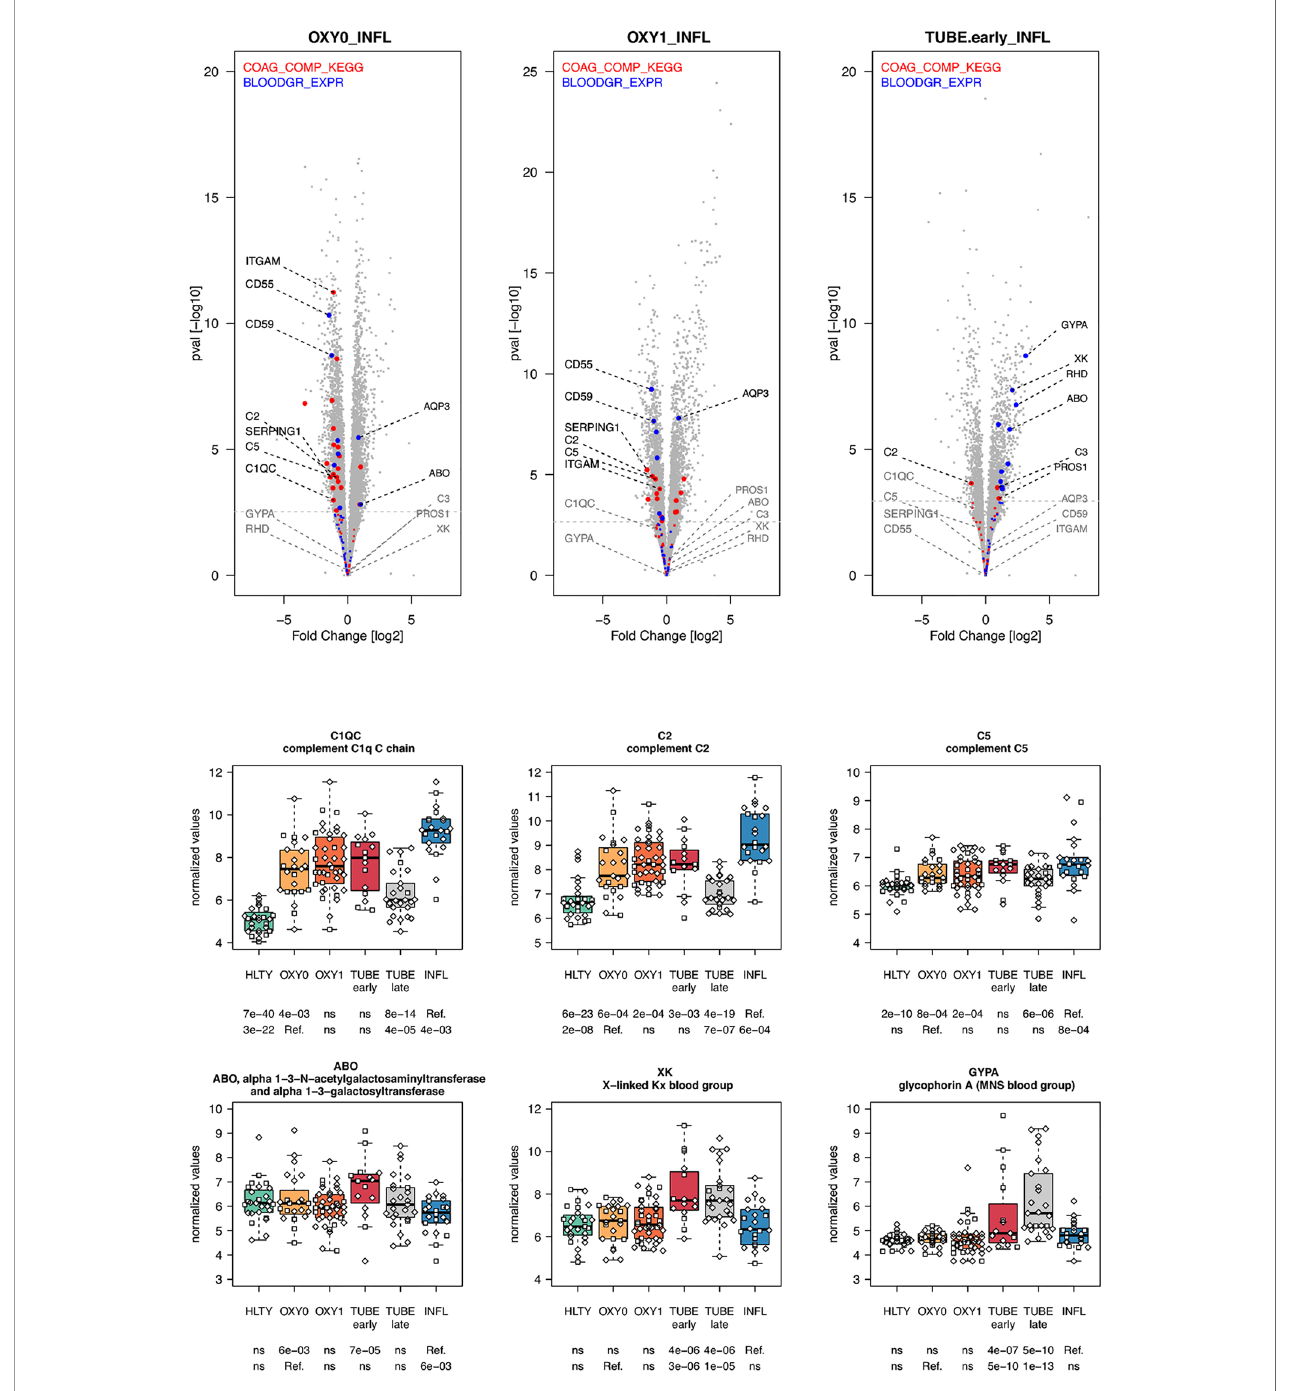
FIGURE 10 | Differentially expressed genes (DEGs) involved in complement system and blood group. Upper panel: for each comparison indicated in the volcano plot header, the distribution of log2 fold changes and P-values of all detected genes is shown as gray dots. Red and blue dots indicate genes involved in complement system and blood group respectively. Genes ’ sets are selected from different GO, REACTOME and/or KEGG pathways (see Supplementary Table 2 ). The dotted horizontal gray line indicates the limit under which – log10(P-value) becomes non signi fi cant once adjusted for multiple testing (adjusted P > 0.01). Lower panel shows detailed expression levels of selected genes involved in complement system and blood groups in the different groups of patients. Groups used for comparisons include SARS-Cov-2 infected patients (no oxygen support [OXY0], oxygen support [OXY1], intubation with sampling within 7 days [TUBE early] or >7 days [TUBE late] after hospital admission), In fl uenza virus [INFL] infected patients and non-infected controls [HLTY]. Adjusted P-values of pairwise comparisons between a reference group (Ref.) and another group are indicated below the x axis. Ref. is taken as [INFL] and [OXY0] on the fi rst and second line,